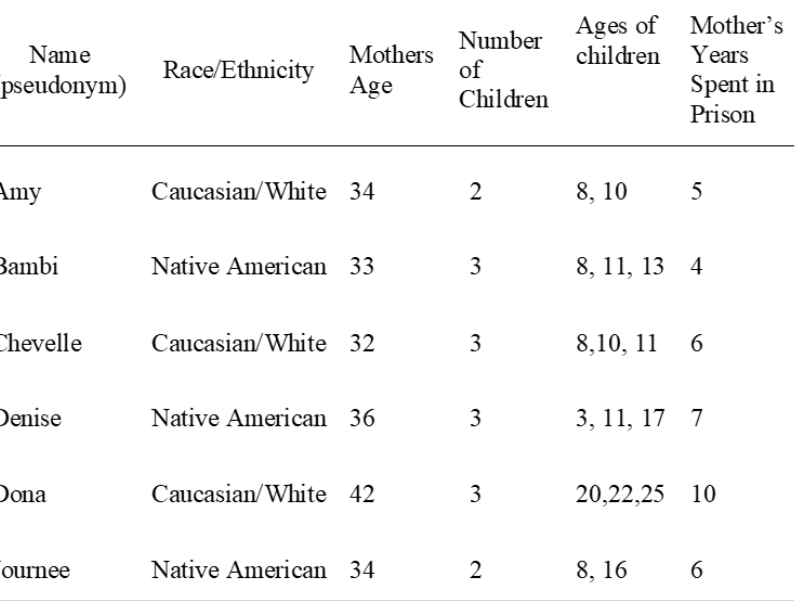
Figure 1. Demographic Information on